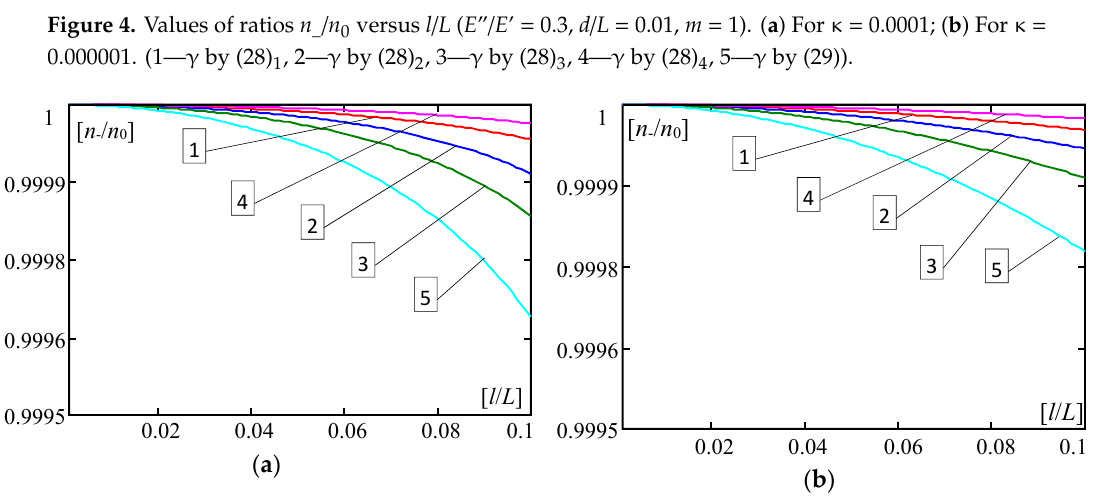
Figure 7. Values of ratios n _ / n 0 versus l / L ( E ”/ E ’ = 0.5, d / L = 0.001, m = 1). ( a ) For κ = 0.0001; ( b ) For κ = 0.000001. (1— γ by (28) 1 , 2— γ by (28) 2 , 3— γ by (28) 3 , 4— γ by (28) 4 , 5— γ by (29)).